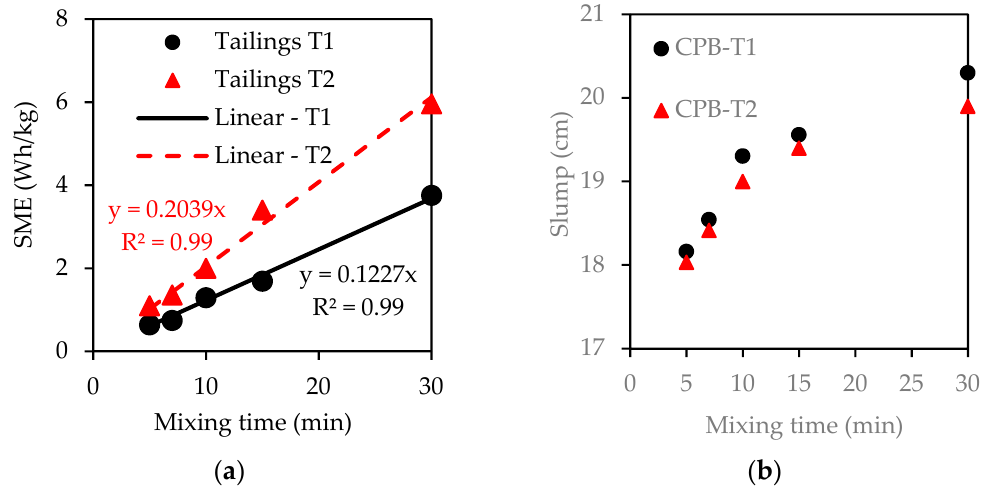
Figure 6. Influence of mixing time on ( a ) SME and ( b ) consistency for CPB-T1 and CPB-T2 mixtures prepared with tailings T1 (M01–M05) and T2 (M13–M17), respectively, using the Omcan SP300AT mixer rotating at 166 rpm.